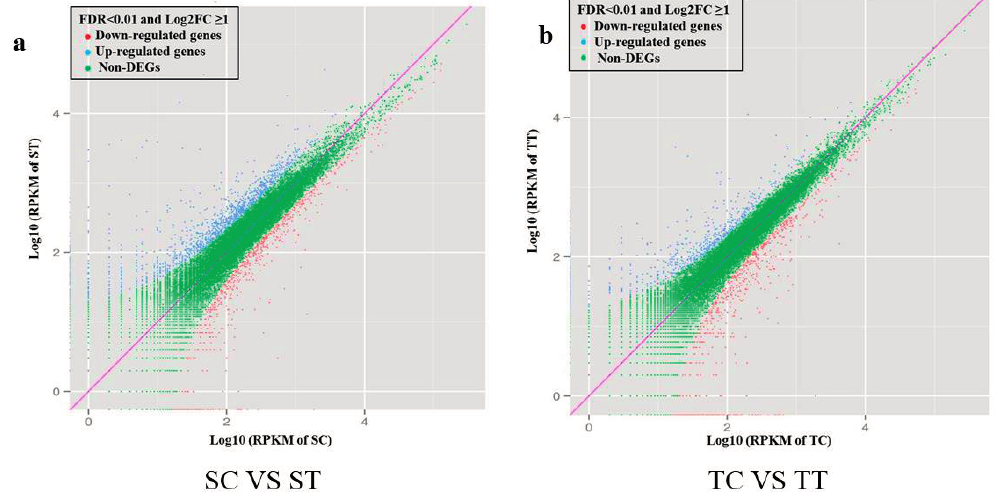
Figure 3. Scatter plot analysis of two sample pairs from Zea mays . ( a ) untreated susceptible maize (SC) and nicosulfuron-treated susceptible maize (ST); ( b ) untreated tolerant maize (TC) and nicosulfuron-treated tolerant maize (TT). RPKM (Reads Per Kilobase per Million mapped reads) were used to represent the expression levels of genes in non-nicosulfuron treated and nicosulfuron-treated libraries in susceptible and tolerant maize. Two parameters, “FDR < 0.01” and “Log2FC ≥ 1” were used as the threshold to evaluate the significance of gene expression difference. Blue and red dots represent the up- or down-regulated transcripts, respectively, and green dots indicate transcripts without significant changes under nicosulfuron